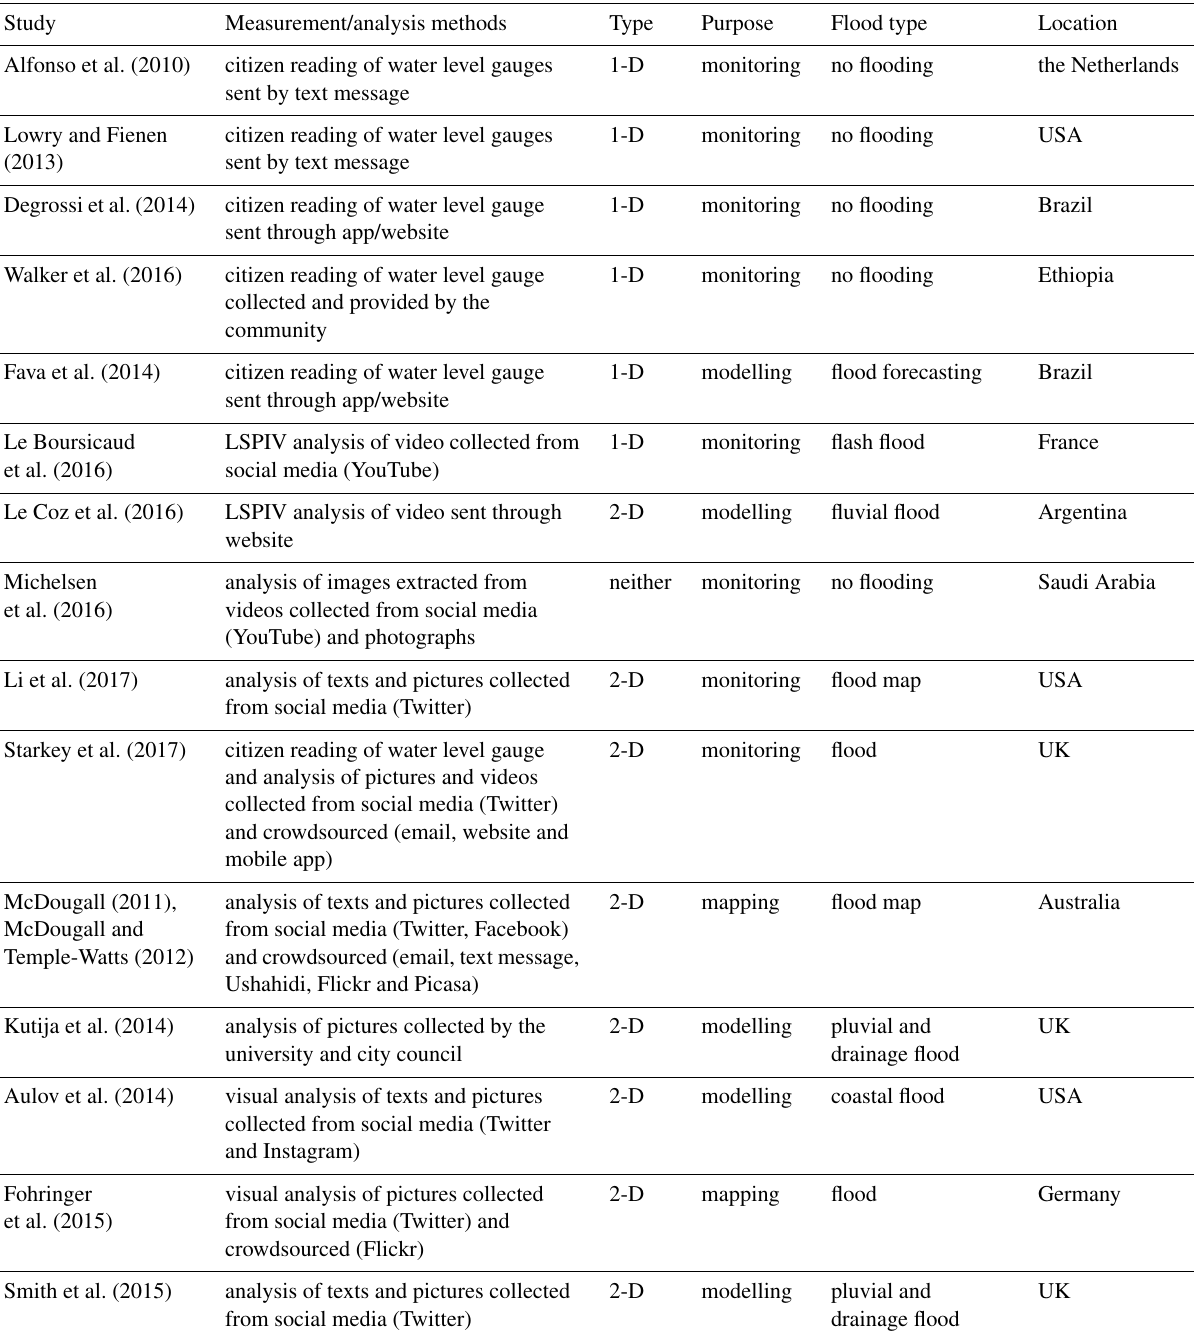
Table 1. Scientific literature on citizen contributions to measurement and analysis of water level